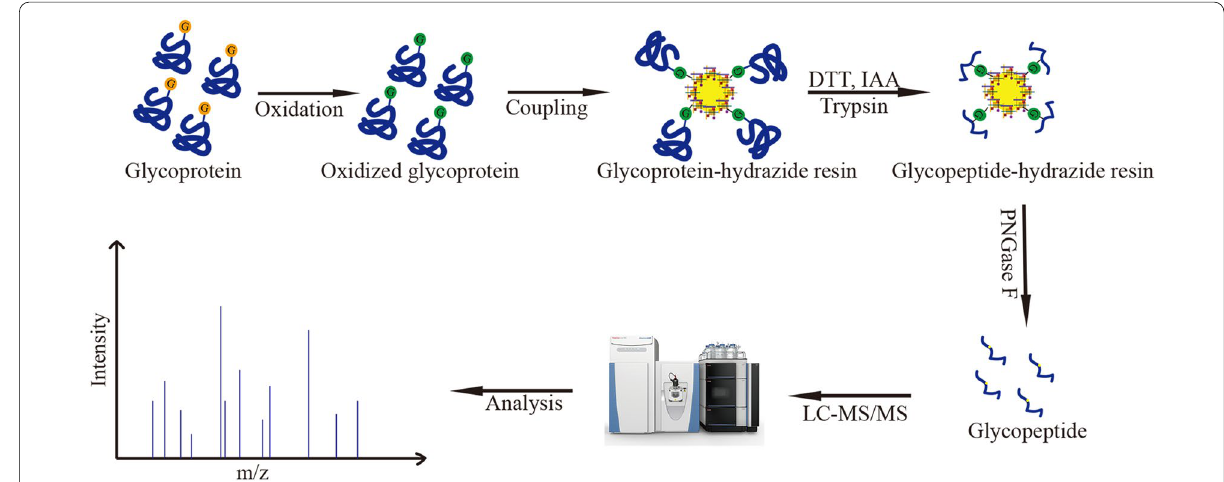
Fig. 1 The schematic workflow of glycosylation analysis using